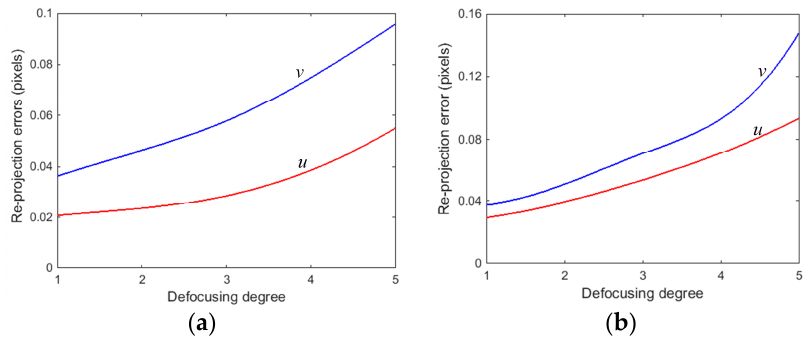
Figure 6. Re-projection errors under different defocusing degrees: ( a ) obtaining the different defocusing degrees using the first method; and, ( b ) obtaining the different defocusing degrees using the second method. Table 3. Average residual error (ARE) of a projector under different defocusing degrees (unit: pixel).